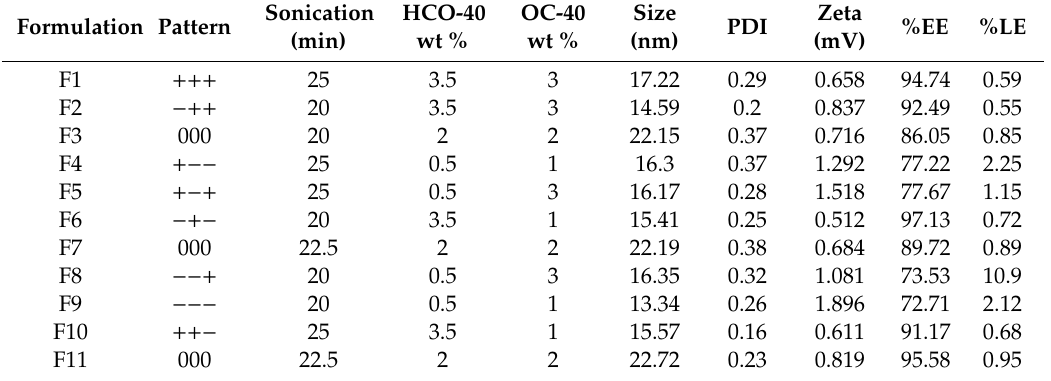
HCO-40: hydrogenated castor oil-40, OC-40: Octyxonyl-40, PDI: poly dispersity index, EE: entrapment e ffi ciency, LE: loading e ffi